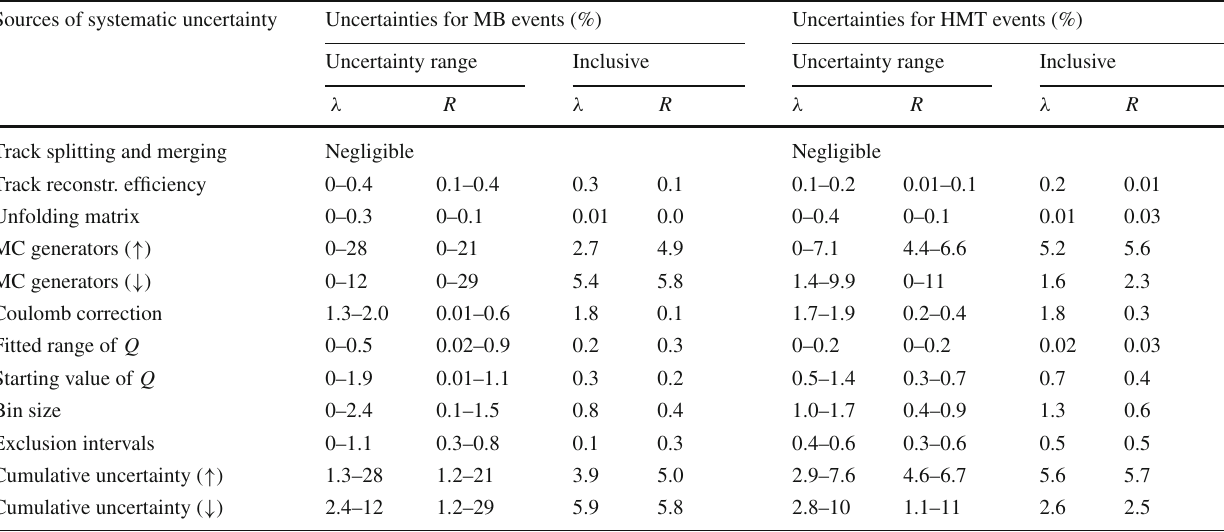
Table 1 Systematic uncertainties (in percent) in the correlation strength, λ , and source radius, R , for the exponential fit of the two- particle double-ratio correlation functions, R 2 ( Q ) , for p T > 100 MeV √ s = 13 TeV for the MB and HMT events. The choice of MC at